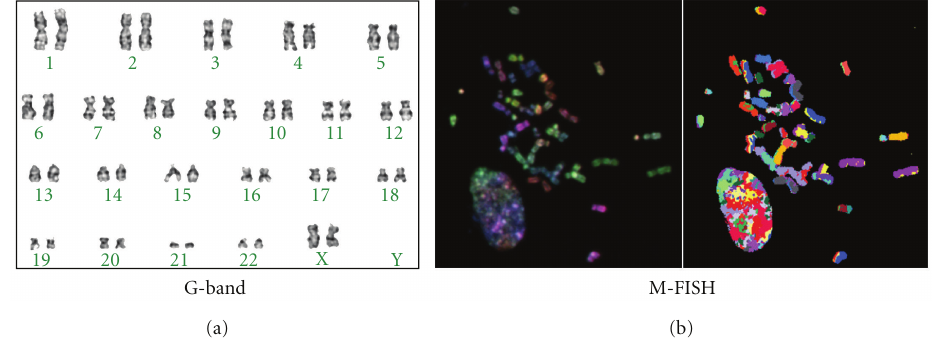
Figure 3: Karyotype of cultured human PDL cells . (a) G-banding staining revealed that the number, banding, and shape of the chromosomes were normal. (b) Multiplex fluorescence in situ hybridization (M-FISH) that visualises each chromosome in a di ff erent colour showed that no chromosomal aberrations, including translocation, had occurred.